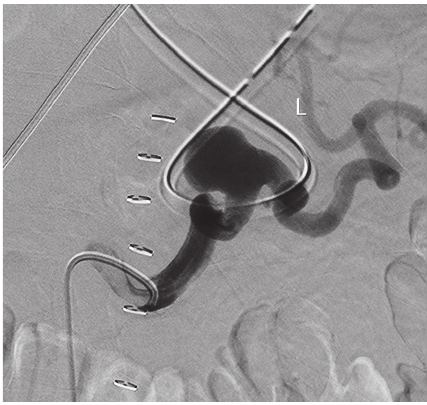
Figure 3: Splenic artery aneurysm with a tortuous aspect during embolisation